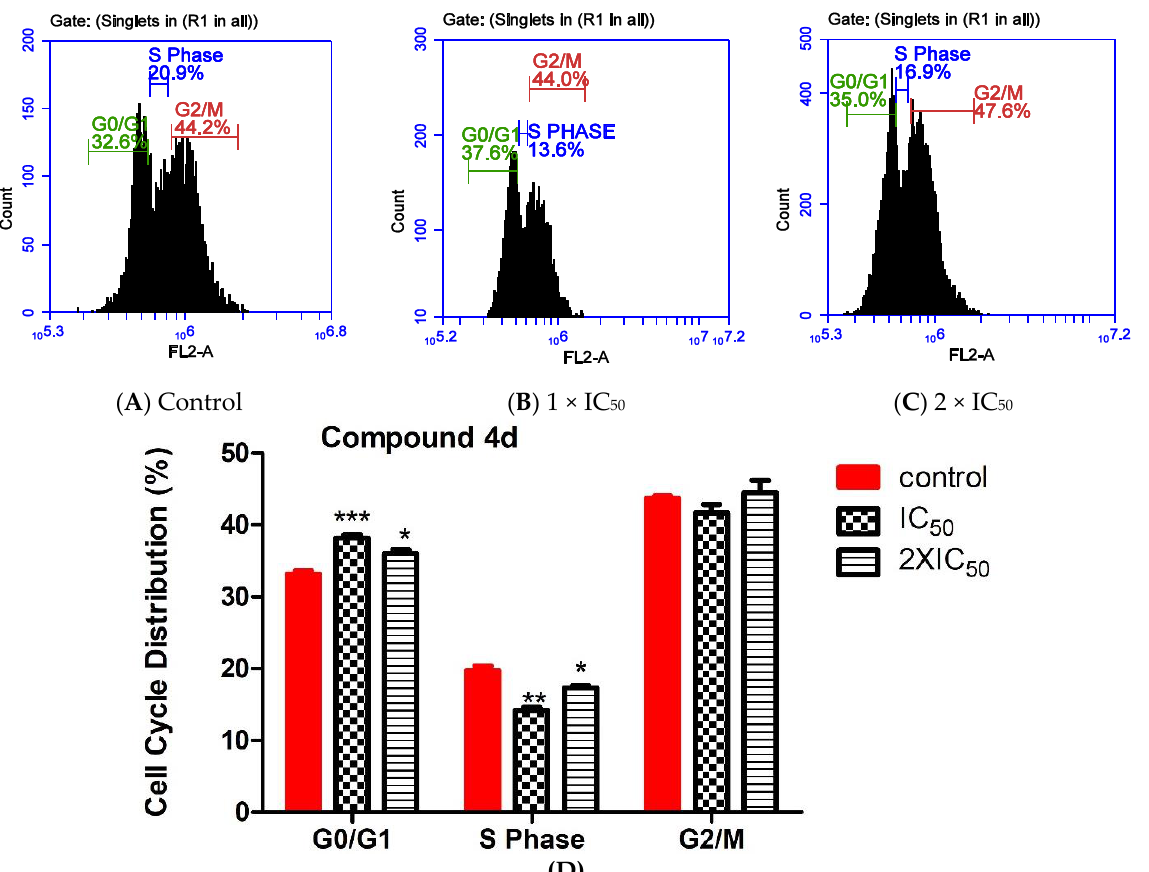
Figure 6. Apoptosis induced by the compound 4d on MCF-7 cell line, assessed through a cell cycle analysis using flow cytometry. PI was used as a fluorescent dye. The representative cytograms ( A ) (untreated) ( B , C ) (IC 50 and 2 × IC 50 of compound 4d ) present DNA content in different phases whereas ( D ) represents a graphical illustration of the results. Asterisks were used to indicate significance values: * p < 0.05; ** p < 0.01; *** p < 0.001.